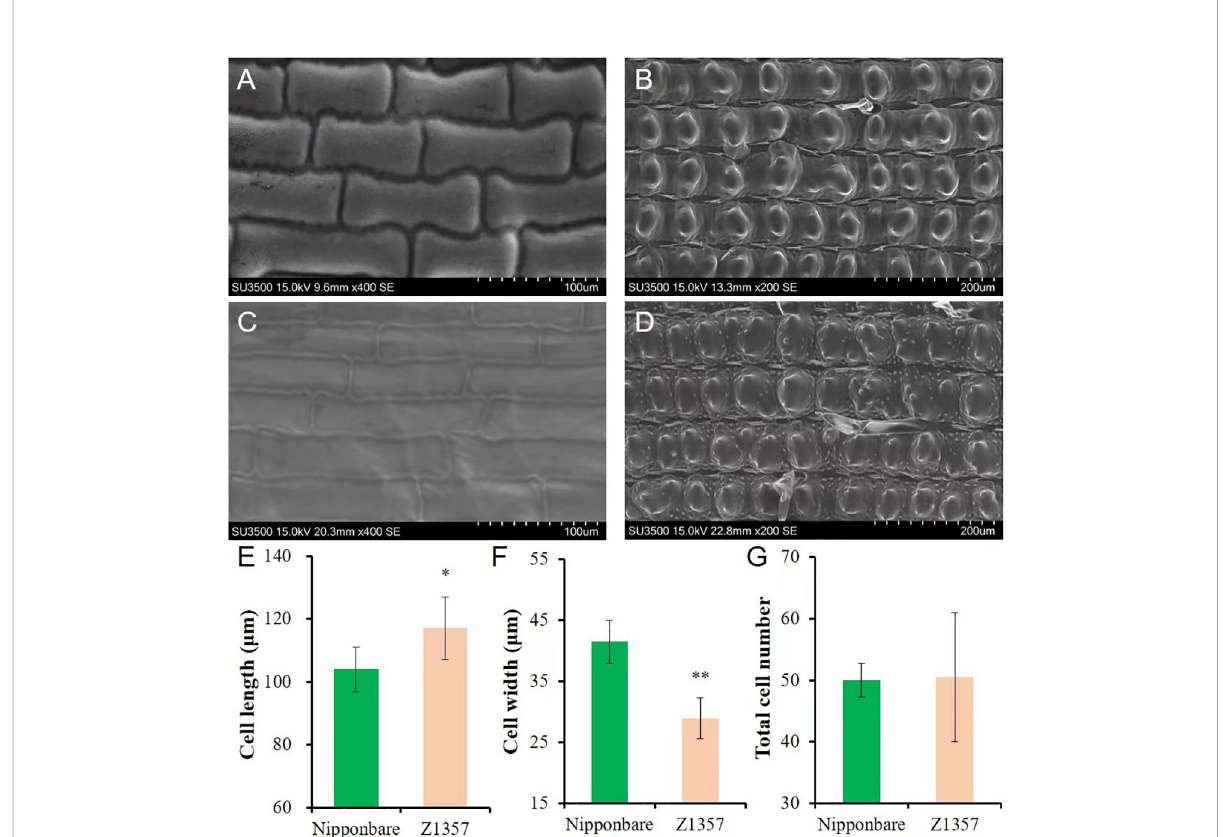
FIGURE 2 Observation and analysis of glume cells between Nipponbare and Z1357 via scanning electron microscope (SEM). A-B: SEM images of glume inner (A) and surface (B) cells of Nipponbare ; (C, D) SEM images of glume inner (C) and surface (D) cells of Z1357; E-F: Comparison of inner glume cell length (E) and width (F) between Nipponbare and Z1357; (G) Comparison of glume surface cells number between Nipponbare and Z1357. * and ** refer to the signi fi cant differences at P < .05 and P < .01, respectively, by the t